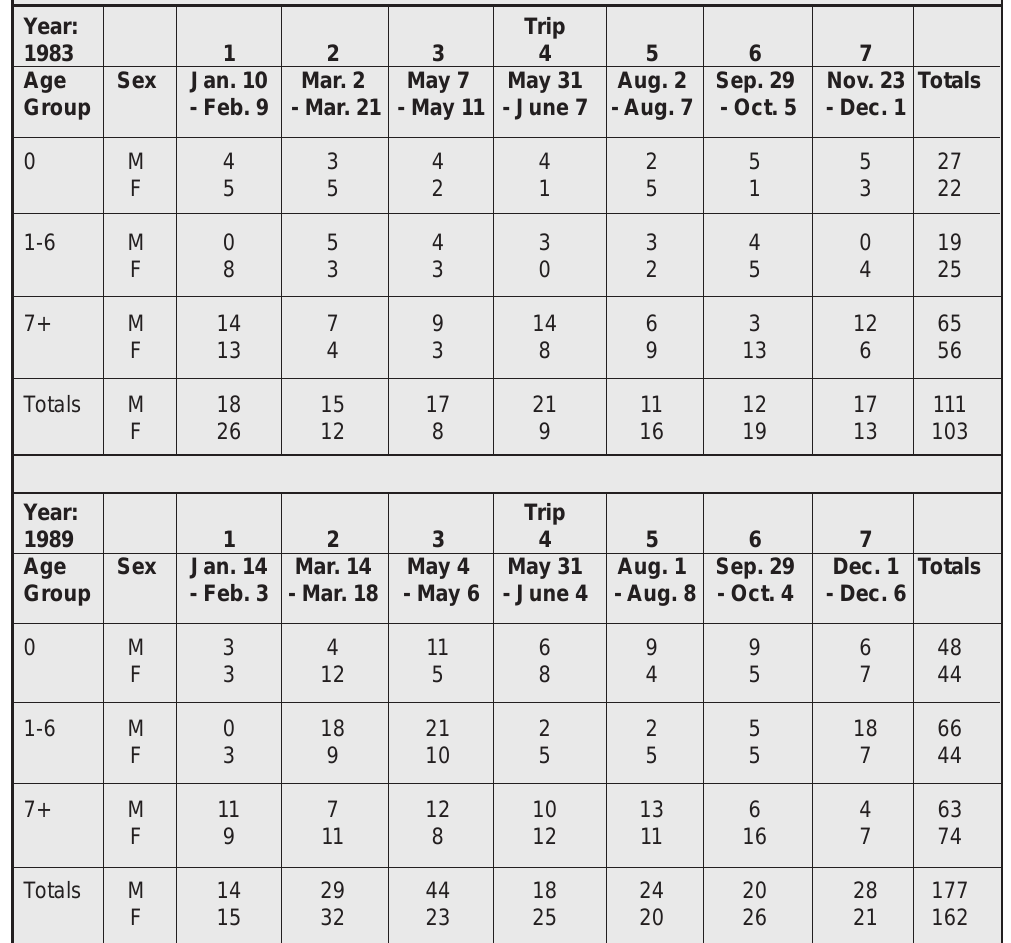
Table 1. Numbers of grey seals by age group and sex sampled during each trip to Sable